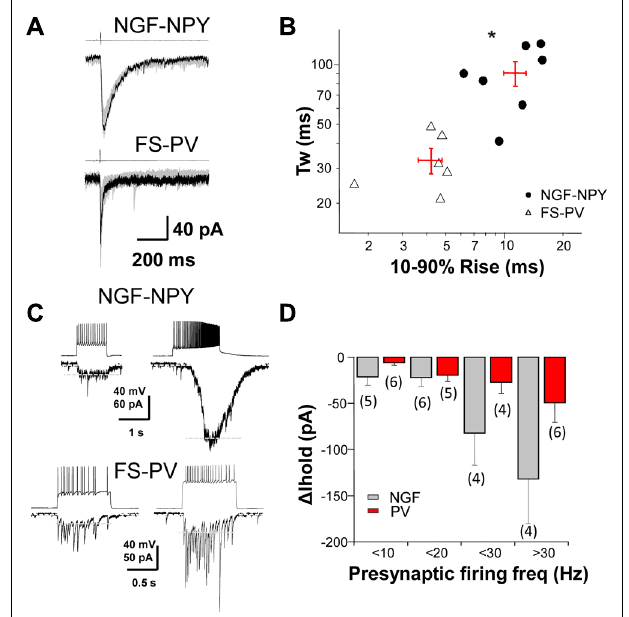
FIGURE 1 | GABAergic dynamics at interneuron-MSN synapses. (A ) A depolarization step to + 40 mV (4 ms in duration) in a NGF-NPY and FS-PV interneuron induced slow and fast IPSCs, respectively, in synaptically connected MSNs. (B) scatterplot in log-log scale of the 10–90% rise time versus the weighted decay time for IPSCs in MSNs in response to action potentials in NGF-NPY and FS-PV interneuron. Each point represents one MSN, with average shown as + in red. IPSCs by FS-PV have faster rise and decay kinetics than NGF-NPY interneurons. *p < 0.05 unpaired two-tailed Student’s t test. (C) Depolarization steps elicit action potentials in NGF-NPY and FS-PV interneurons that evoke GABAergic current in synaptically connected MSNs. High frequency action potential firing in NGF-NPY interneuron induced a large shift in holding current, while similar frequency in FS-PV interneuron induced only a moderate shift. Holding current ( (cid:3) I hold ) as indicated by white dashed lines was assessed after low pass filtering (2–5 Hz). Note that individual IPSCs in the FS-PV paired MSN persist under high frequency. (D) Summary of the average shift in holding current for presynaptic firing frequencies of < 10, < 20, < 30, and > 30